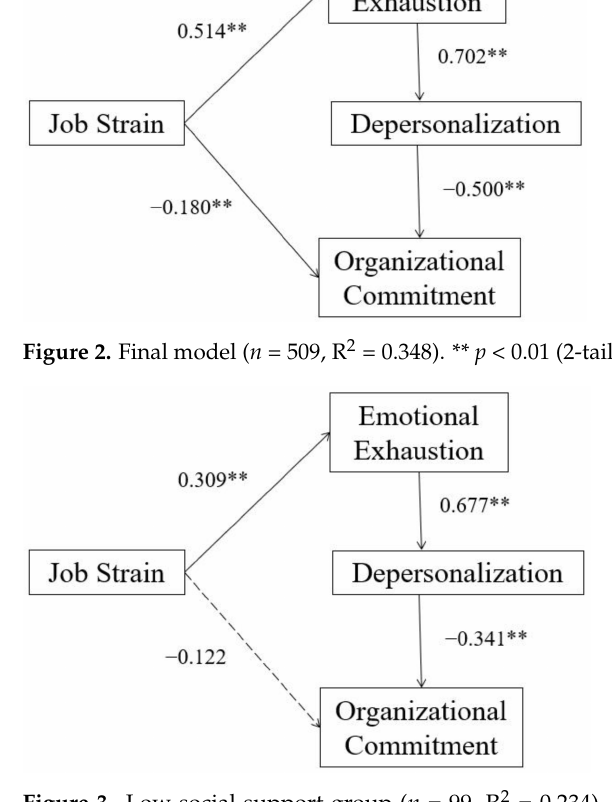
Figure 3. Low social support group ( n = 99, R 2 = 0.234). ** p < 0.01 (2-tails); dotted line means unsignificant coefficients.